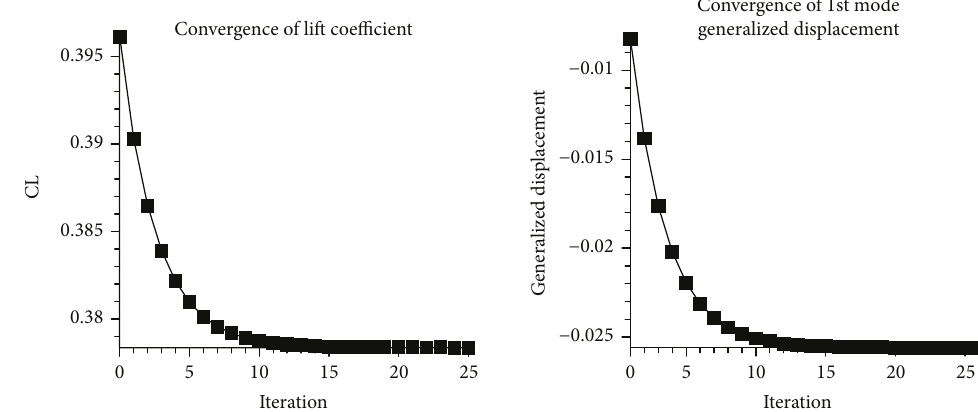
Figure 9: The convergence history of lift coe ffi cient and the 1st mode displacements by CFD/CSD method.